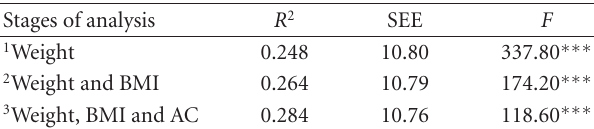
Table 4: Stepwise regression analysis summary for Systolic Blood Pressure (SBP) showing changes in multiple regression coe ffi cient of determination ( R 2 ) with addition of di ff erent variables.